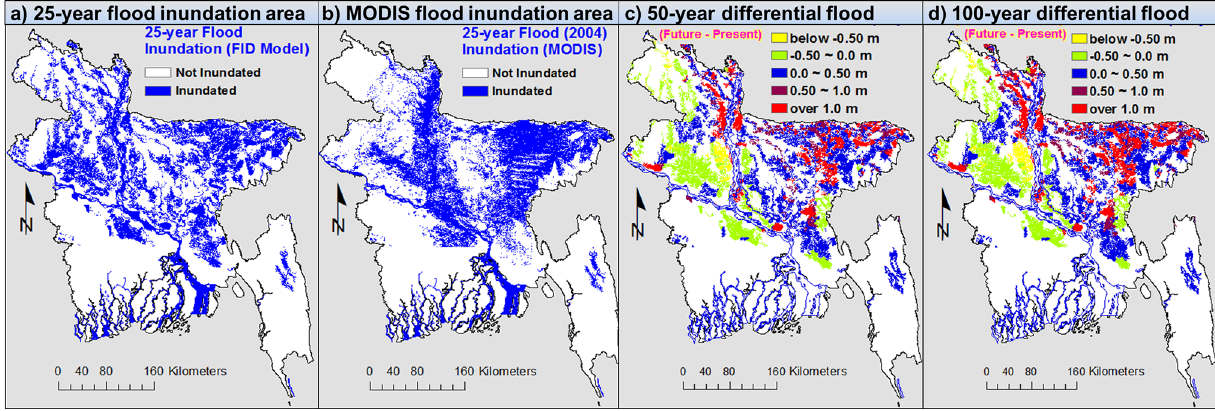
Figure 5. The 25-year flood inundation area produced with FID model (a) and MODIS image (b) data. The change between future and present flood inundation depth for 50-year flood (c) and 100-year flood (d) with existing levee